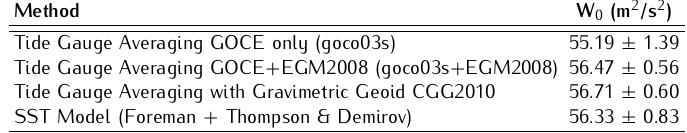
Table 5. Summary of W 0 results using 19 years of water level data for Canada using Pacific and Atlantic tide gauges and SST interpolated from oceanic models (add 62636800.00 m 2 /s 2 to values in